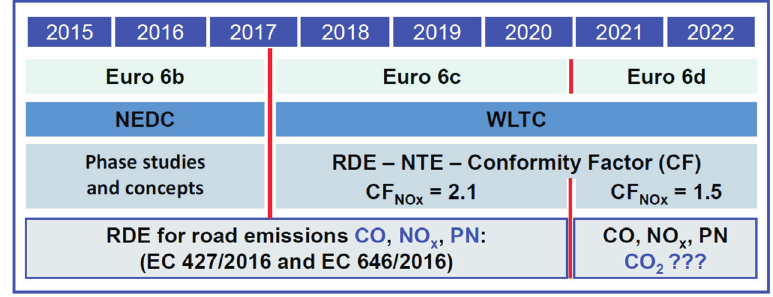
Fig. 1. RDE tests requirements in Europe [2, 3]